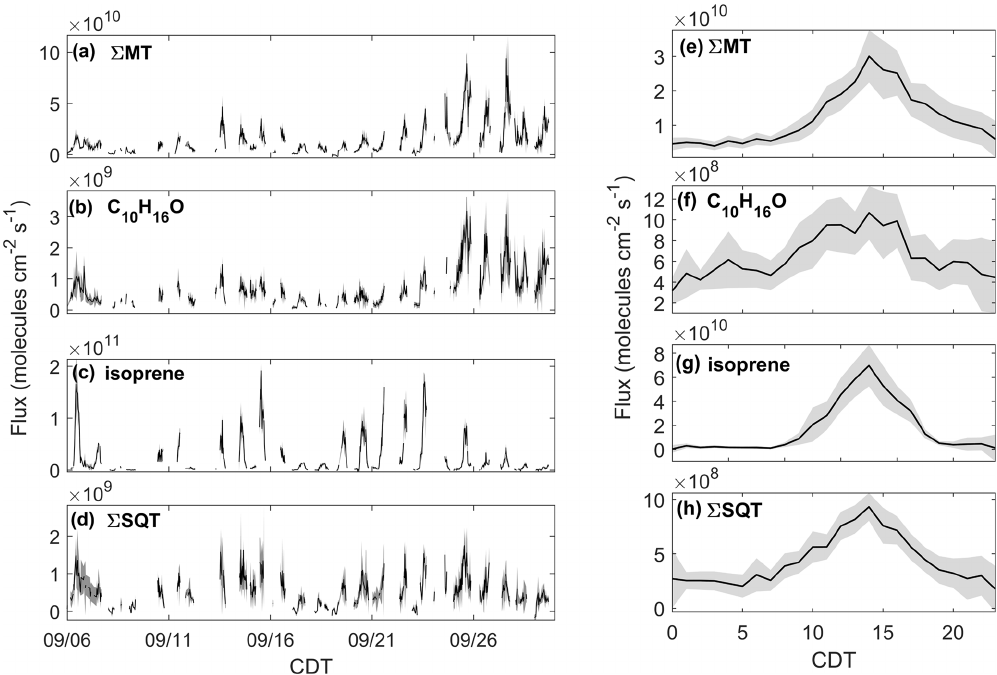
Figure 4. Observed fluxes of (a) (cid:54) MT, (b) C 10 H 16 O, (c) isoprene, and (d) (cid:54) SQT from 6–30 September 2020 with shaded uncertainties. Also presented are diel profiles of (e) (cid:54) MT, (f) C 10 H 16 O, (g) isoprene, and (h) (cid:54) SQT. Diel profile shaded regions are 95% confidence